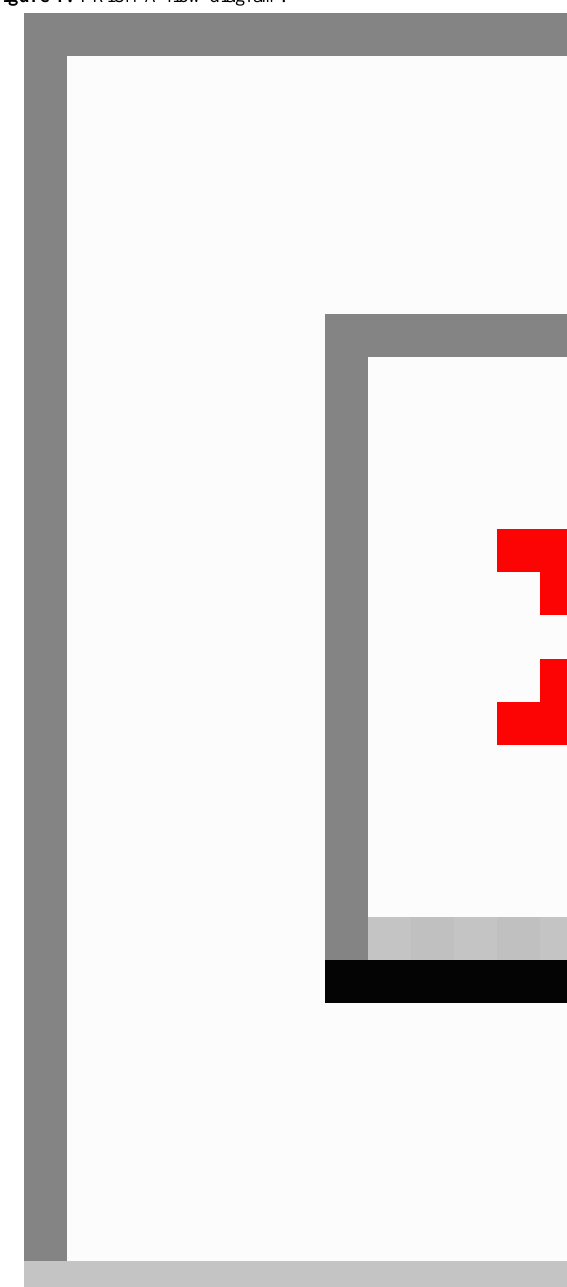
Figure 1. PRISMA flow